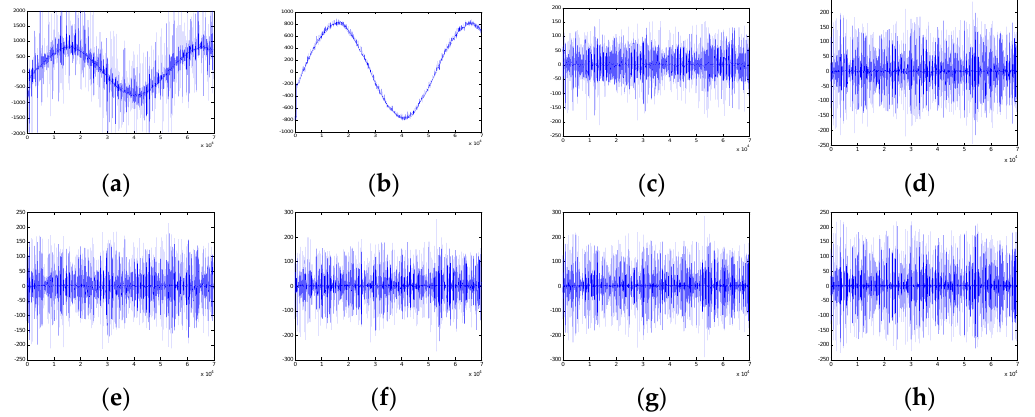
Figure 7. Waveforms of phase-A current and the mode coefficients serials under No. 1 state. ( a ) Waveform of phase-A current. ( b – h ) Waveforms of mode coefficients serials from 1st level to 7th level.